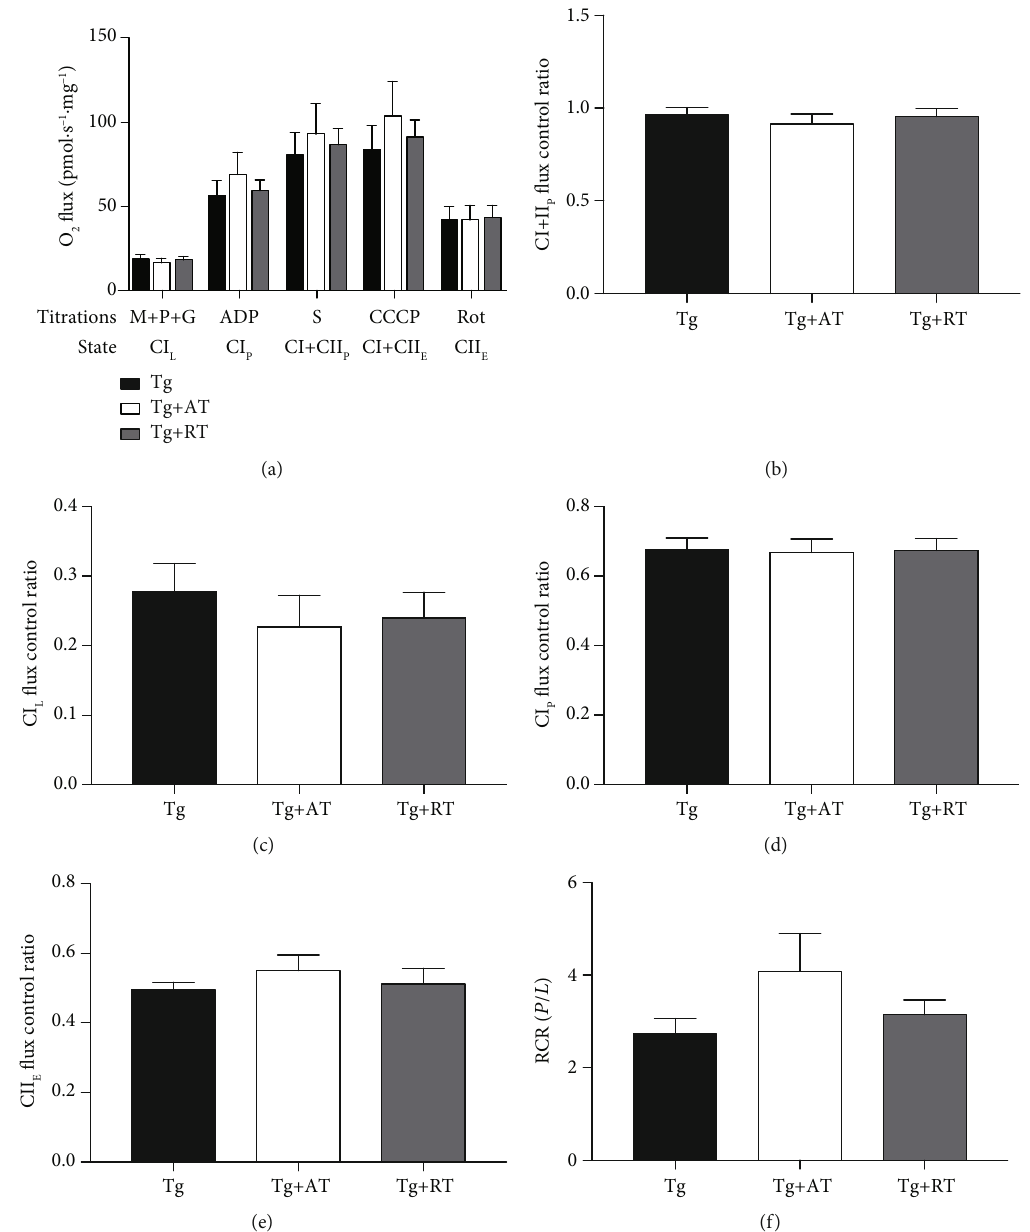
Figure 3: Una ff ected mitochondrial respiration of the hippocampus in exercise-trained 3xTg-AD mice. (a) Mass-speci fi c oxygen (O the hippocampus determined in situ by a substrate-uncoupler-inhibitor titration protocol, including complex I-supported LEAK (CI through addition of malate, pyruvate, and glutamate (M+P+G); complex I-supported oxidative phosphorylation (OXPHOS) (CI addition of adenosine diphosphate (ADP); complex I+II-supported OXPHOS (CI+II transfer system (ETS) capacity (CI+II ) by stepwise titration of carbonyl cyanide m-chlorophenyl hydrazine (CCCP); and complex II ETS E ) by addition of rotenone (Rot). (b) Respiratory control ratio (RCR) determined by dividing CI (CII E were calculated by normalizing mass-speci fi c fl uxes to maximal electron transfer system capacity (CI+II for (c) CI , (d) CI , (e) CI+II , and (f) CI+II . Data presented as mean ± SE . Tissues assayed from the nonexercised group (Tg), the L P P E aerobic-trained group (Tg+AT), or the resistance-trained group (Tg+RT) ( n = 10 /group). Di ff erences determined by one-way